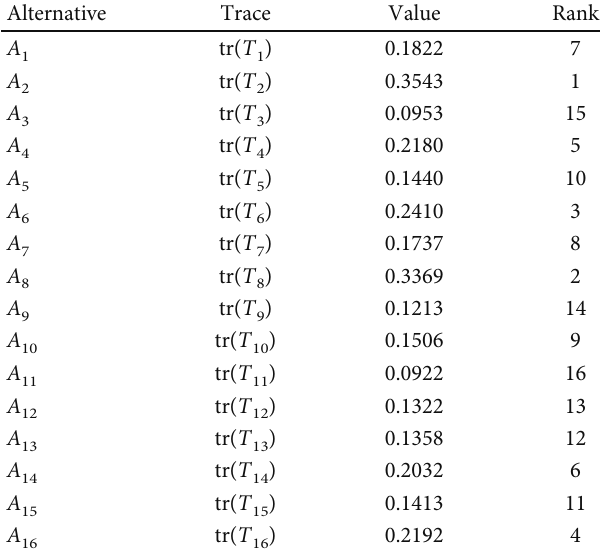
Table 7: Alternatives ranked according to MCRAT